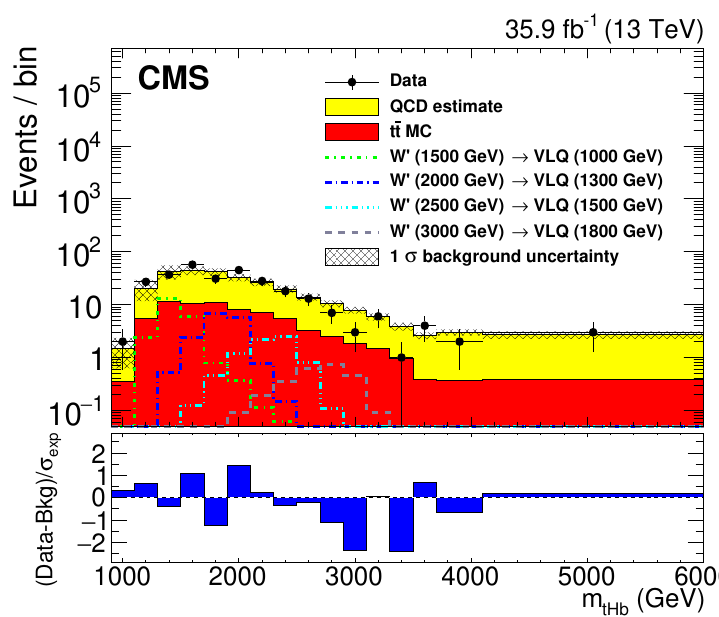
Figure 7 . Reconstructed W mass distributions ( m tHb ) in the signal region, compared with the 0 distributions of estimated backgrounds, and several benchmarks models. The signal distributions include the contributions from W decays to both the T and B assuming equal branching fractions. 0 The uncertainties shown in the hatched region contain both statistical and systematic uncertainties of all background